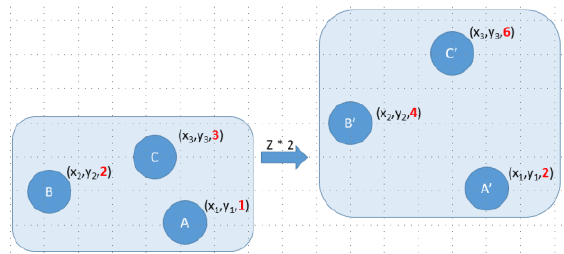
Figure 5: Exaggeration of point cloud